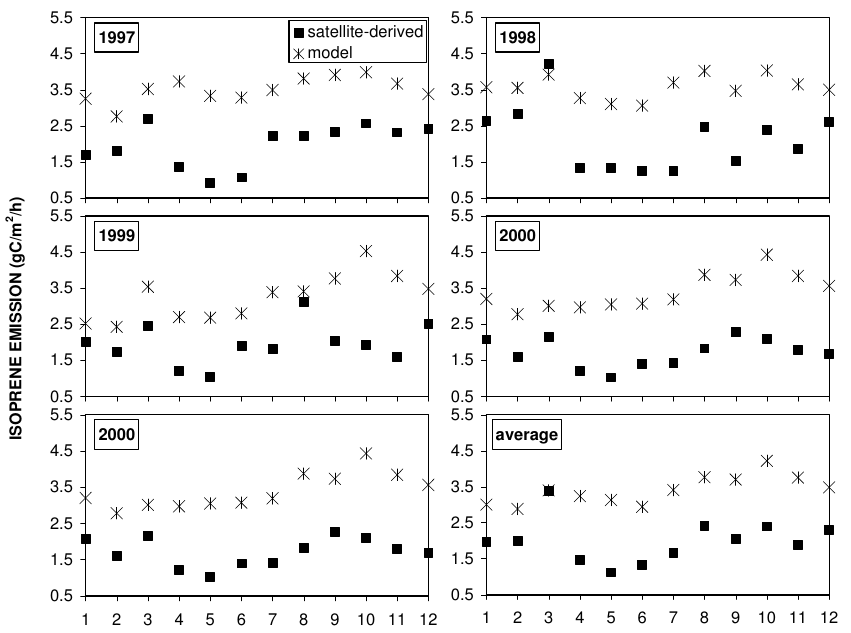
Fig. 7. Comparison of simulated and satellite-derived monthly total isoprene emissions (10:00–12:00LT) over tropical South America for individual years from 1997 to 2001, May to